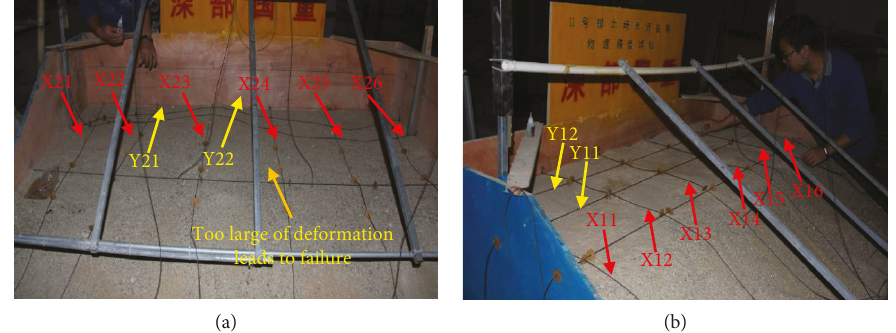
Figure 6: Laying and welding of optical fi bers. (a) Laying of optical fi bers in the lower layer. (b) Laying of optical fi bers in the upper layer.